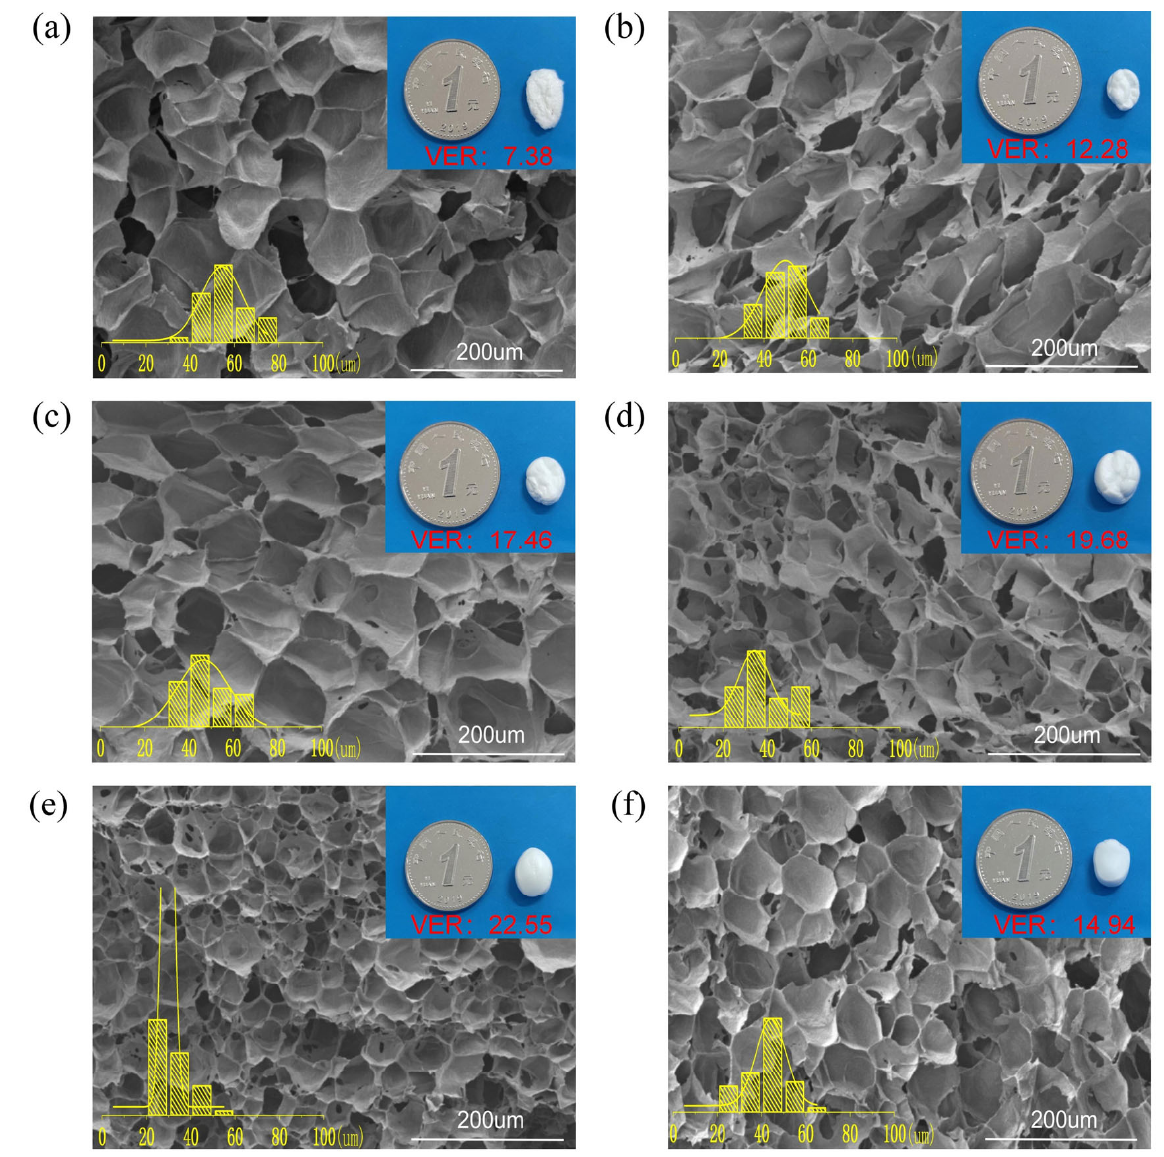
Figure 5. Morphology and size distribution of cells at 120 °C for ( a ) PBAT, ( b ) PPCE ‐ 0, ( c ) PPCE ‐ 0.6, ( d ) PPCE ‐ 0.9, ( e ) PPCE ‐ 1.2, and ( f ) PPCE ‐ 1.5.